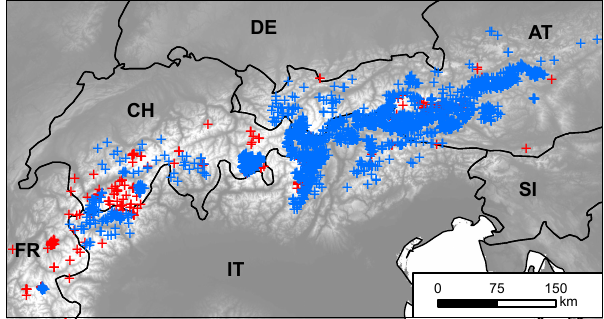
Table 1. Landsat scenes used to calculate the SAVI.